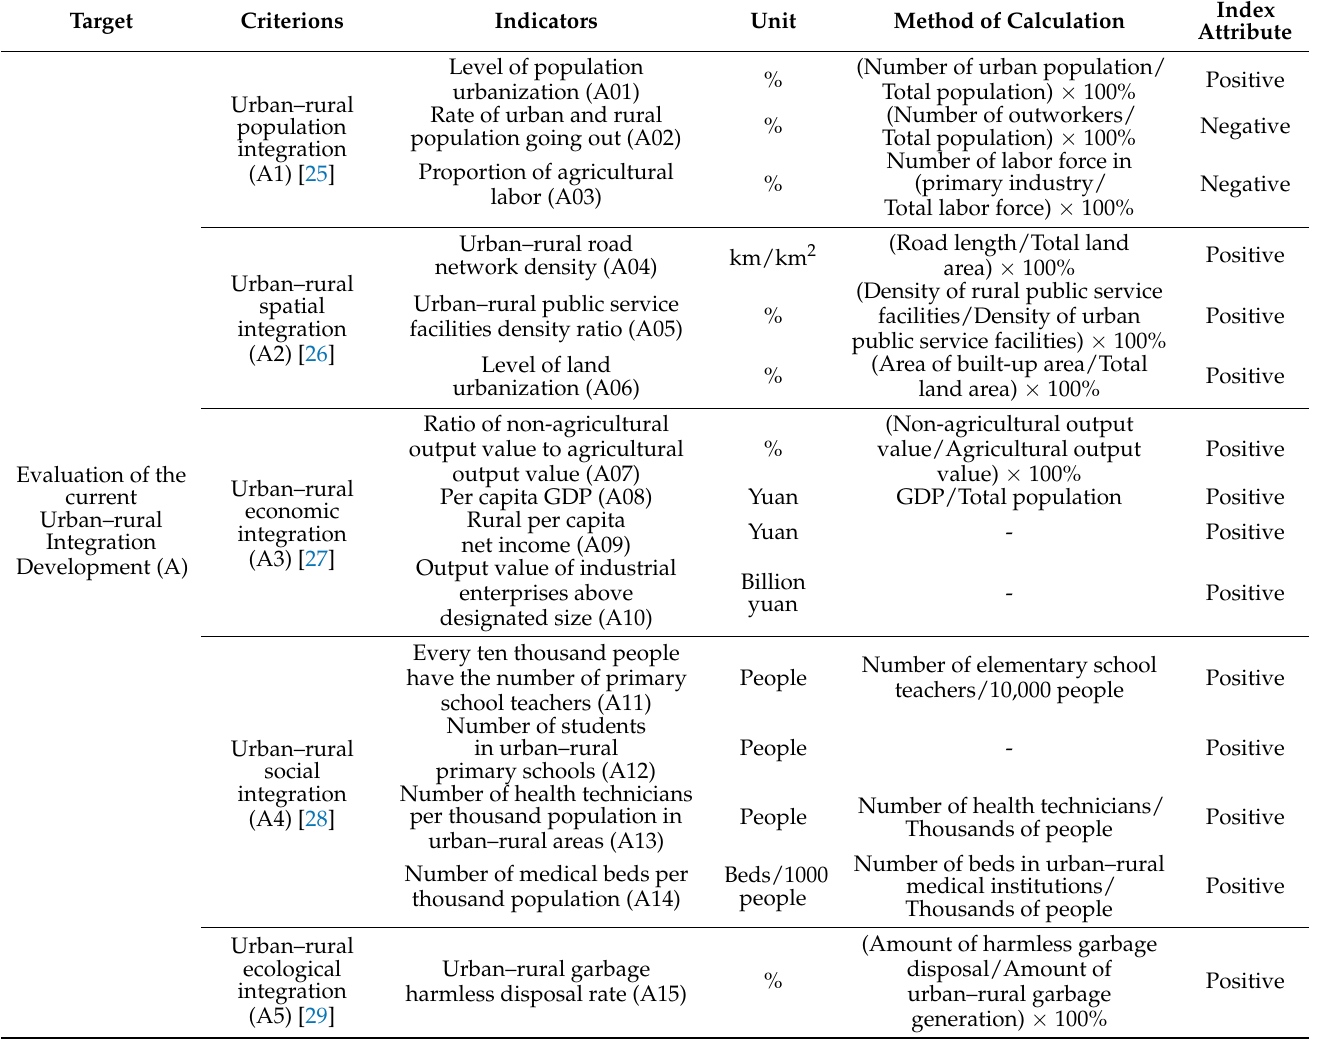
Table 1. Evaluation system of the current urban–rural integration development